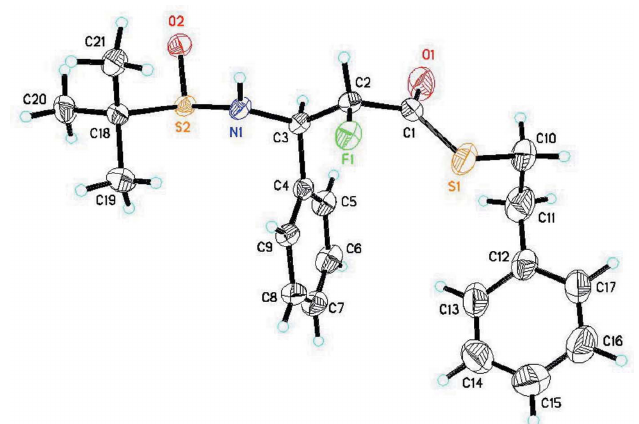
Figure 1 The molecular structure of the title compound. Displacement ellipsoids are drawn at the 50% probability